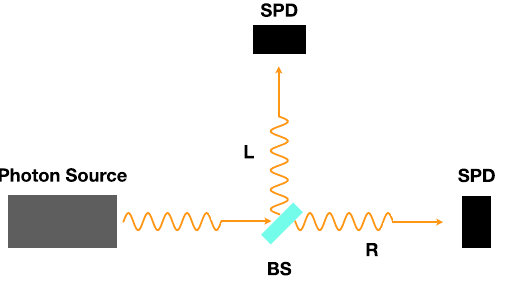
Figure 2. Schematic representation of a double detector setup for generating and measuring superposition state. A single photon is emitted from the source and hits a beam splitter (BS), generating a superposition of R . A pair of single photon detectors (SPD) are placed in R and L